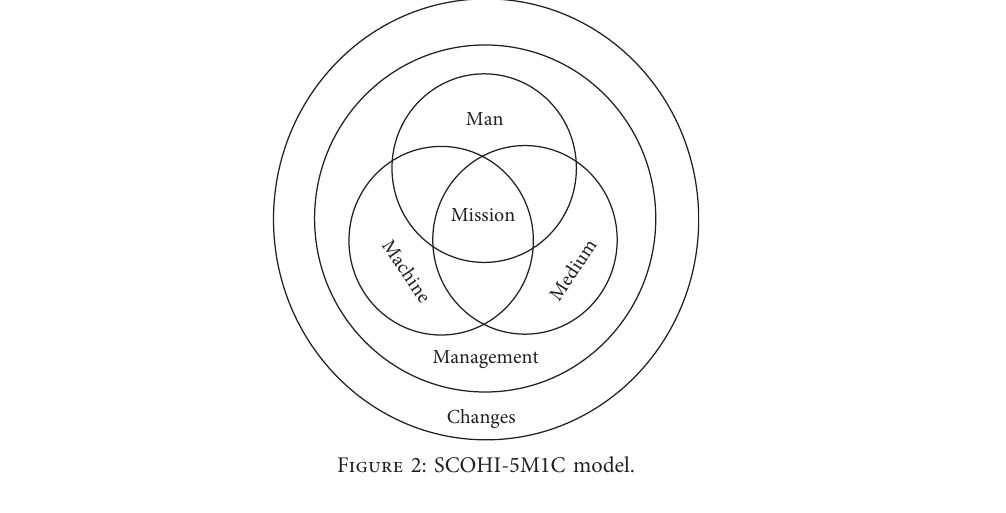
Table 1: “5M” and its implications.